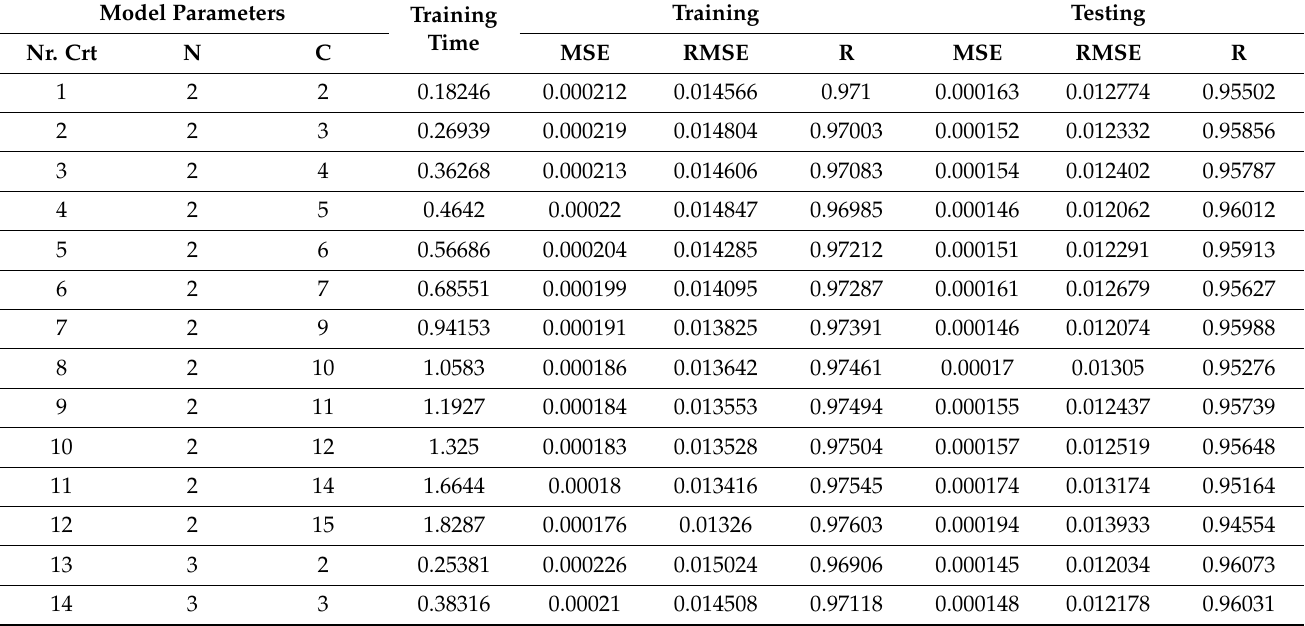
Table 3. Results of modelling and prediction using the ANFIS